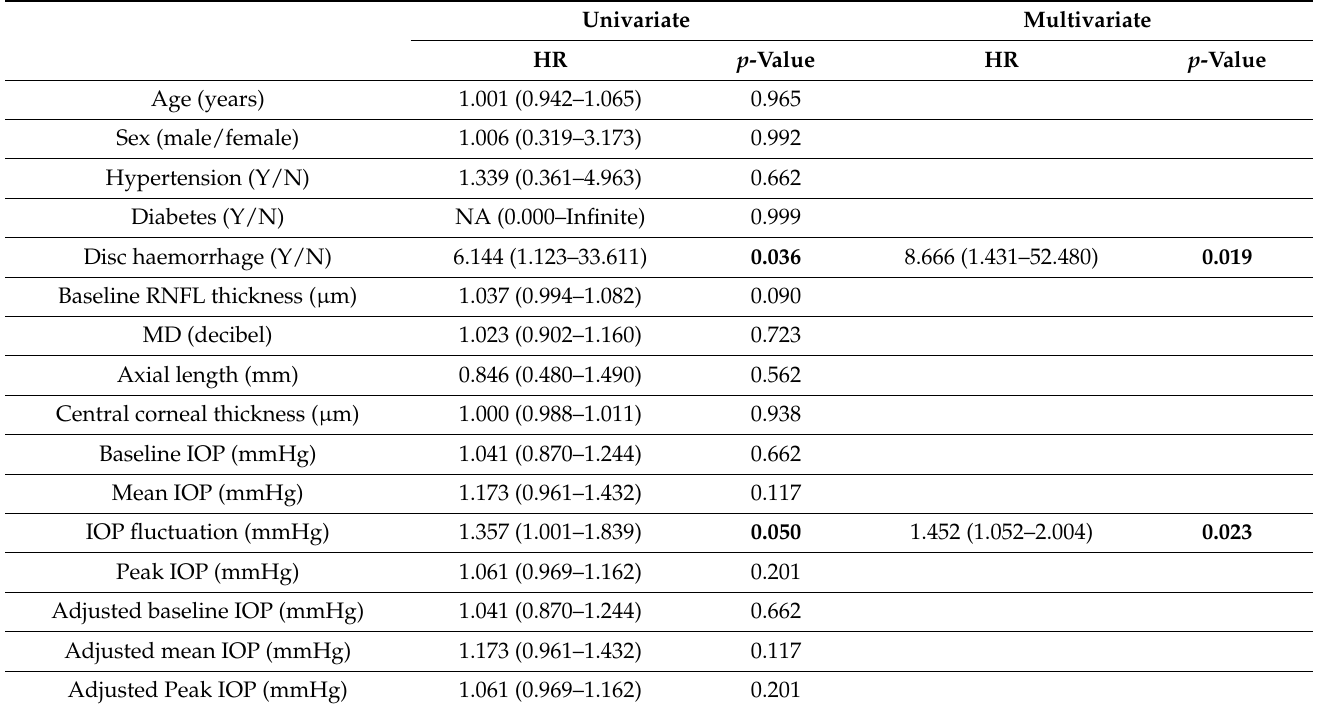
Table 4. Cox regression for the LRS